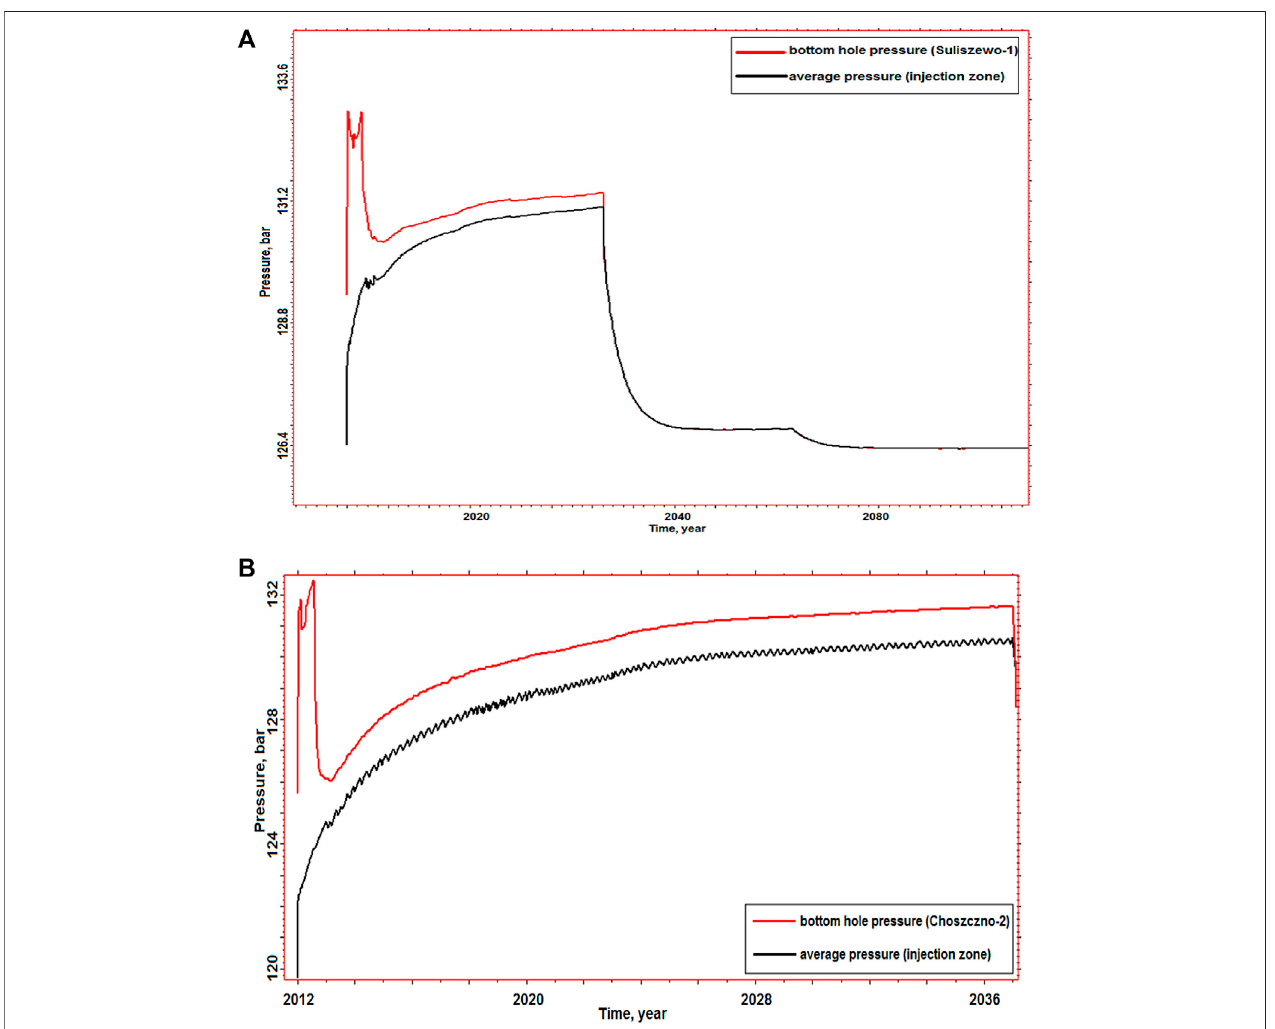
FIGURE 4 | Bottomhole pressure in the (A) Suliszewo-1 and (B) Choszczno-2 well and average formation pressure in the injection zone.